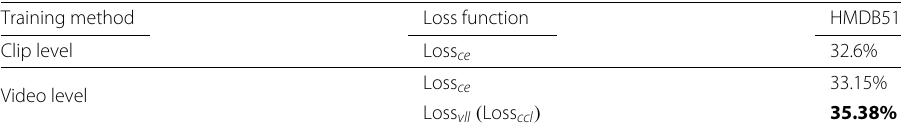
Table 3 Accuracy of clip-level training and video-level training with different loss functions